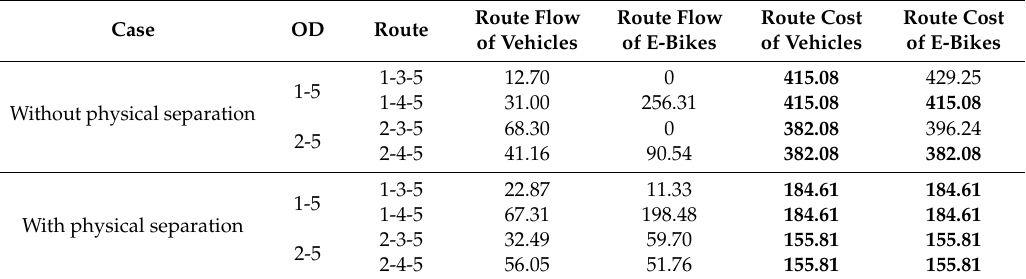
Table 3. Route flows of the NCP for cases with and without physical separation.